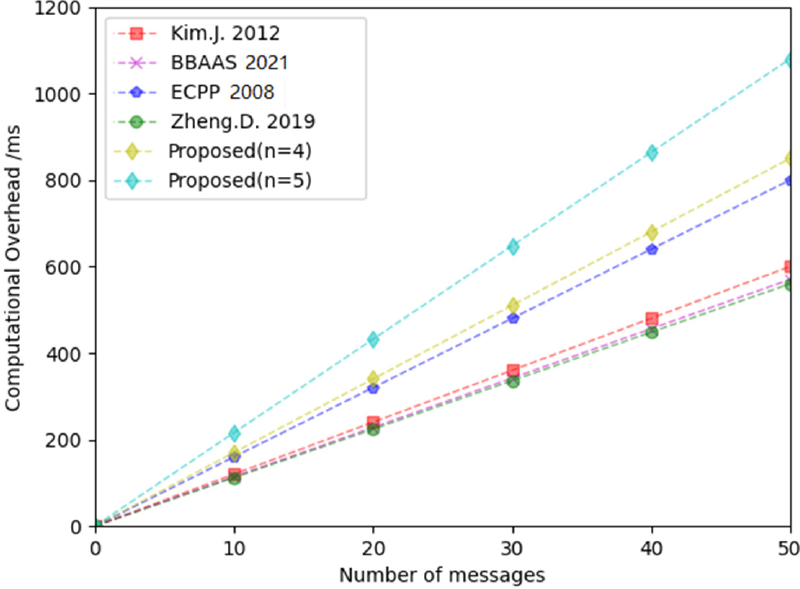
Figure 8. Computational overhead of RSUs in the pre-certification process [15,21,23,24].